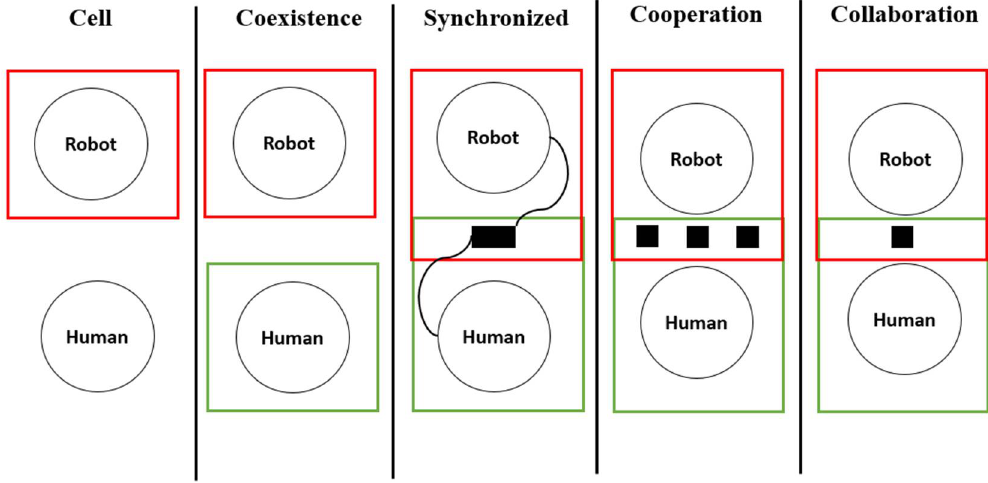
Figure 1. Types of Human–Robot Interaction [6].